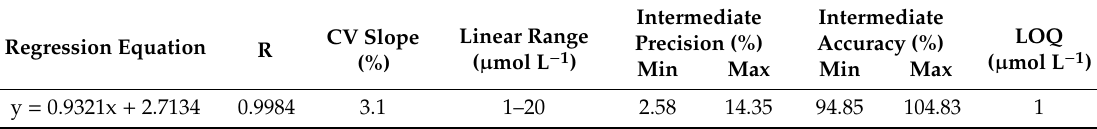
Table 2. Validation data ( n =